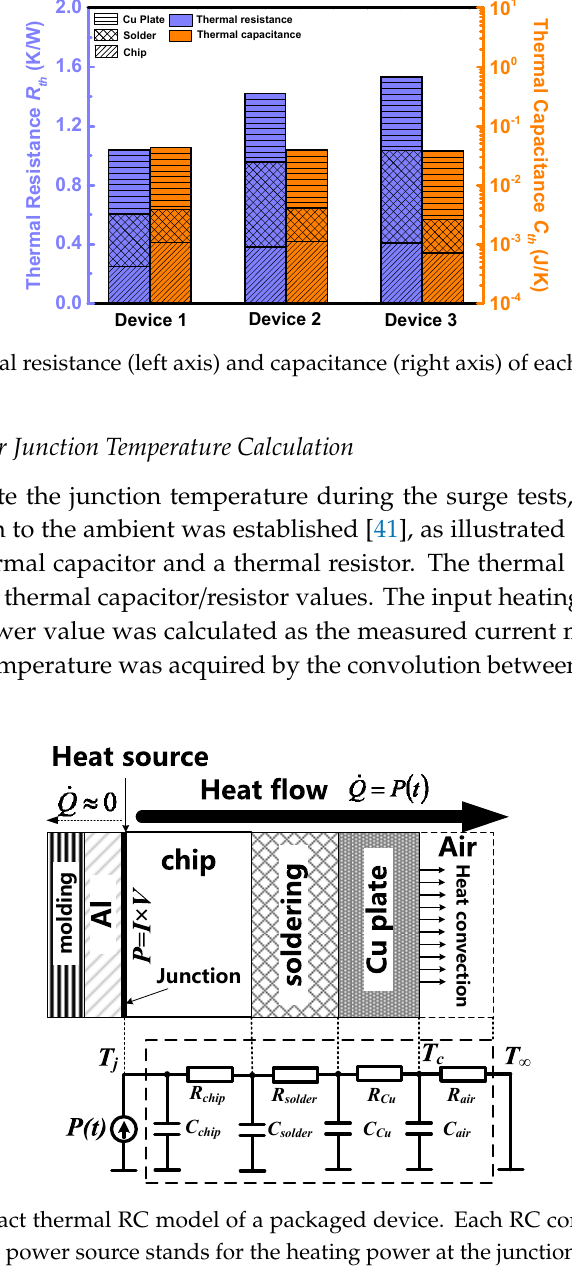
10 of 21 Figure 10. The surge current capability (left axis) and surge current density capability (right axis) of the three devices. 4. Discussion In this section, to discuss the influences of device designs in both electrical and thermal aspects on the surge current capability of the MPS diodes, an advanced thermal RC model is presented for junction temperature calculation in surge conditions, with current distribution non-uniformity considered. The thermal resistance and capacitance of each material layer was extracted from thermal impedance measurement results, and then modified according to the current distribution non- uniformity explained in Section 3.1. After that, the thermal data, as well as the measurement results of the current and voltage waveforms, were imported into the RC model to calculate the junction temperature during the surge process. The calculation results are discussed and analyzed. 4.1. Thermal Impedance Measurement In order to compare the thermal designs of the three devices, their thermal impedance was measured on a Mentor Graphics Power Tester 1500A (provided by Mentor Graphics Corporation, Wilsonville, OR, USA), according to the test standard JESD51-14 [38]. The junction-to-case thermal impedance was extracted from the structure function (Figure S3a) [38,39], which was calculated from the cooling curves. It was observed that the thermal impedance of Devices 2 and 3 is quite similar, and they have close junction-to-case thermal resistances (1.43 K/W and 1.54 K/W, respectively). On